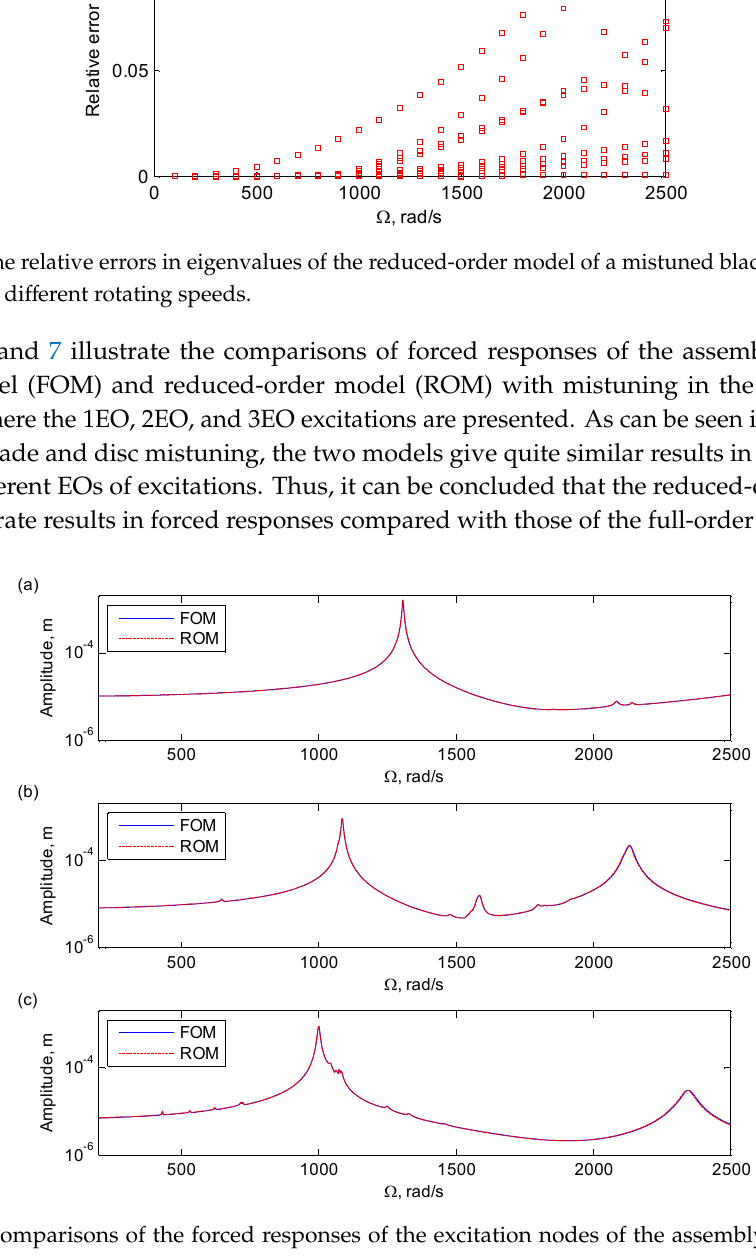
Figure 7. Comparisons of the forced responses of the excitation nodes of the assembly with disc mistuning between the full ‐ order model and reduced ‐ order model with excitations of ( a ) 1EO, ( b ) 2EO, and ( c ) 3EO. The full ‐ and reduced ‐ order models contain 103,563 and 7179 DOFs, respectively.